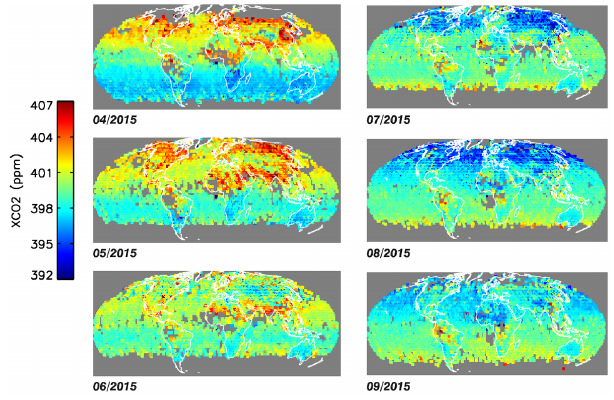
) from Figure 4. Maps of X CO from OCO-2 from April 2015 through 2 2 September 2015, bias corrected and selected with data quality flag and averaged on 2 ◦ by 2 ◦ grid.